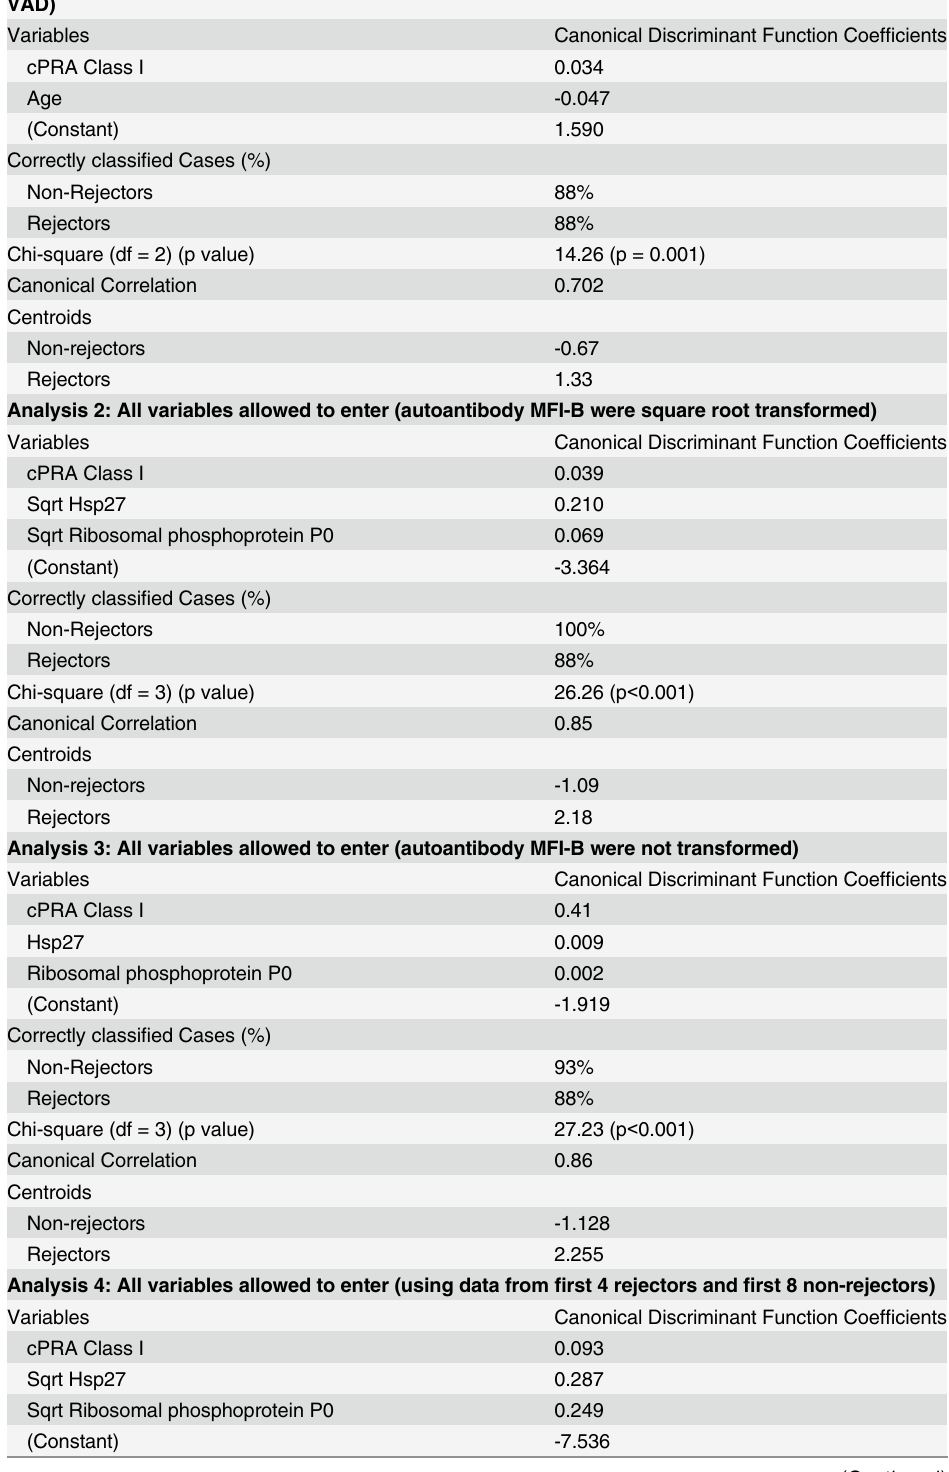
Table 3. Step-wise discriminant analyses of pre-transplant variables that predict rejection outcome (Yes/No) (maximum 3